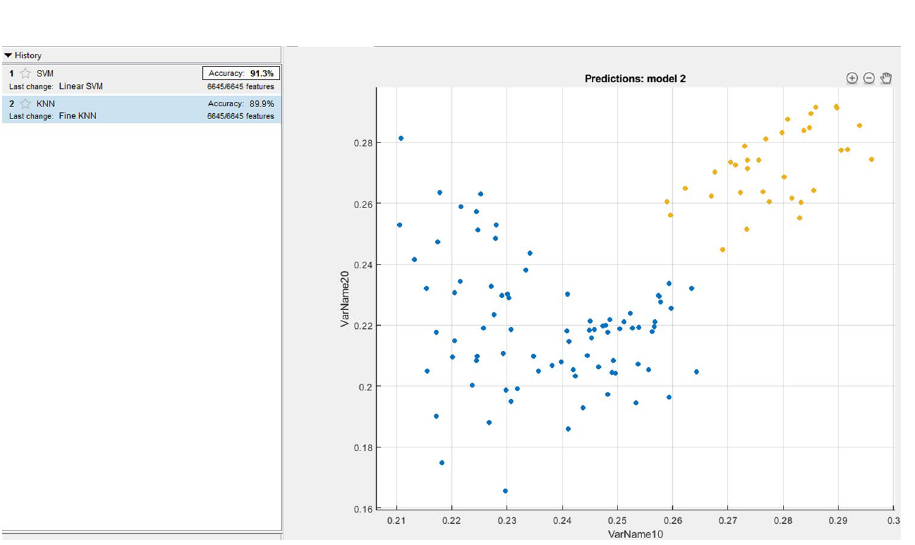
Figure 6. SVM and KNN analysis on PR